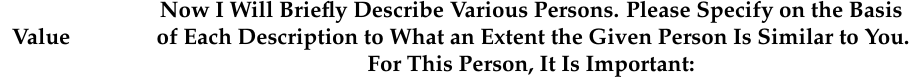
Table 1. The measurement scale for the Schwartz